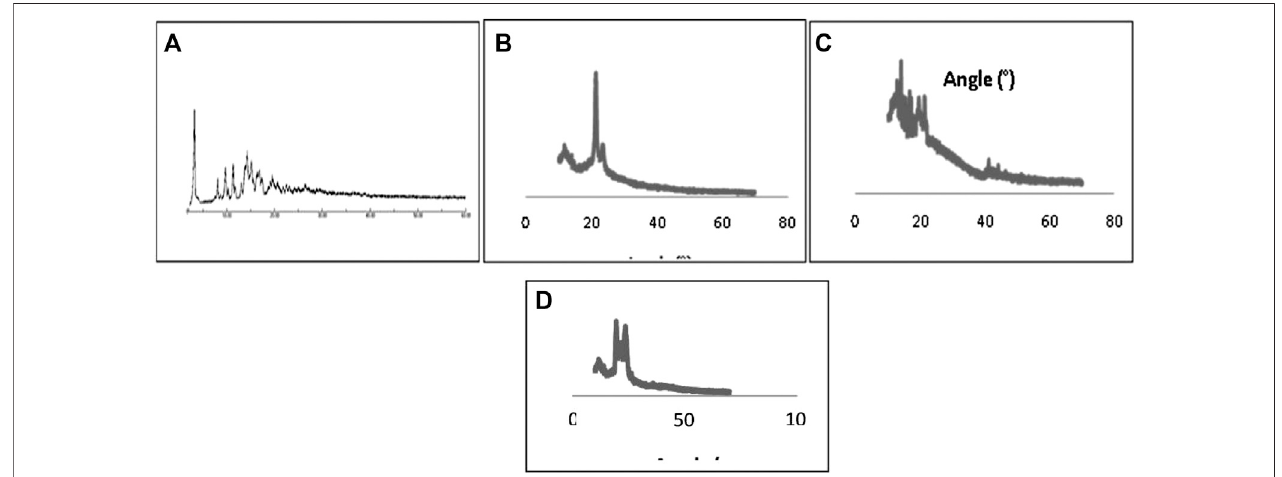
FIGURE 3 | X-ray diffraction pattern of Pure drug (A) , Tamoxifen citrate (B) , B-SLN (C) , D-SLN and SMD-SLN (D) .